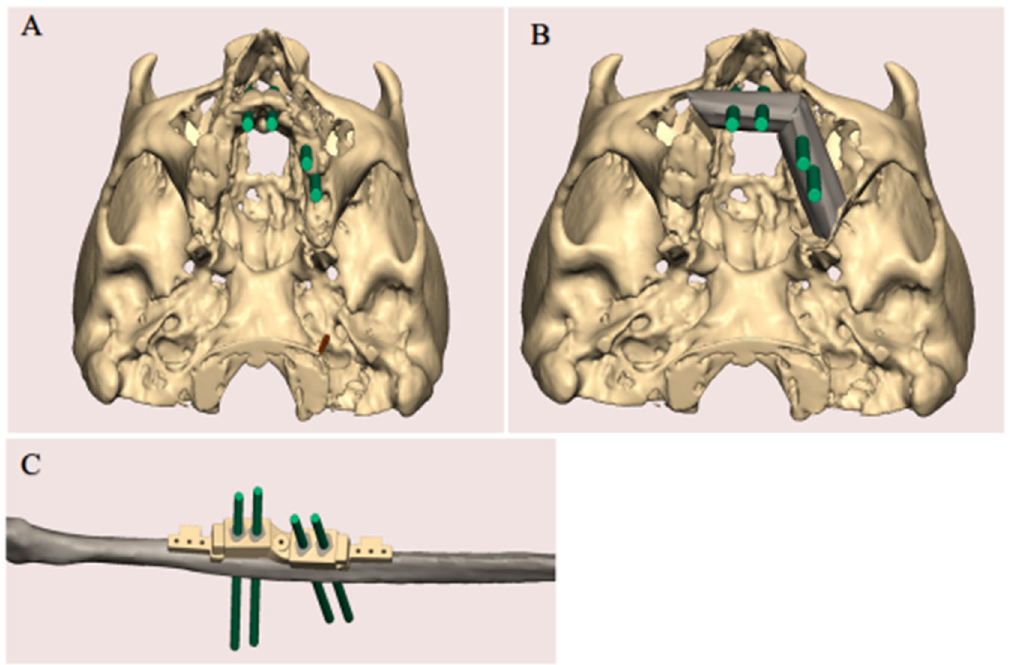
Figure 1. SDS planning. ( A ) Optimal implant positions based on the patient’s native dentition were confirmed. ( B ) The resection planes of the jaw were established. ( C ) The position of the fibula reconstruction based on the planned implant positions.